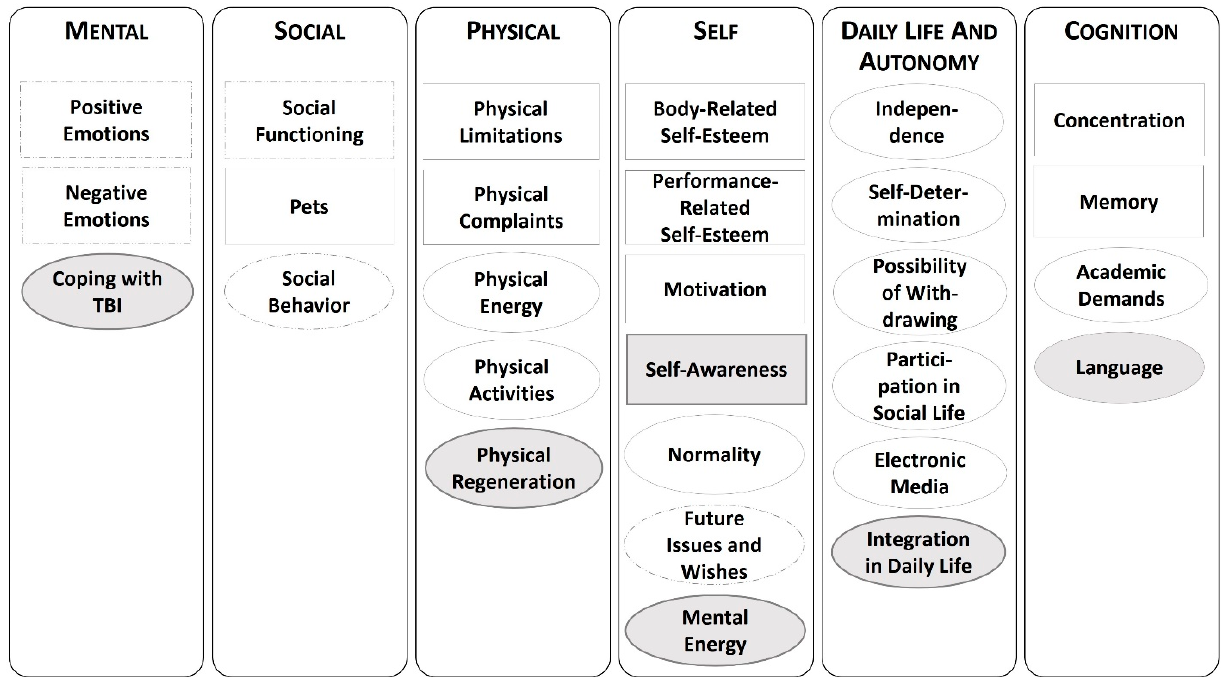
Figure 1. Category system. Note: Deductive categories are shown in rectangles, and inductive cat- egories are in ovals. Gray-shaded categories contain only statements of children and adolescents after traumatic brain injury (TBI); categories with dashed outlines are further specified by subcate- gories.